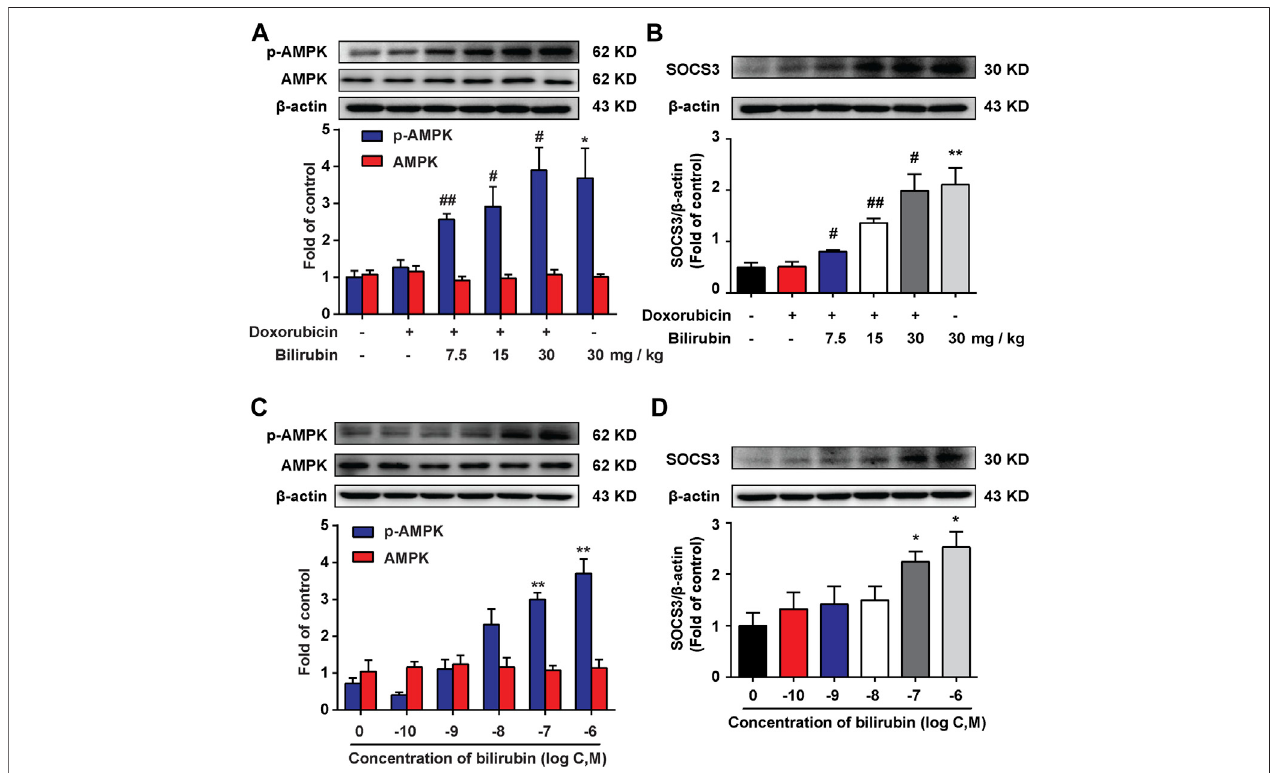
FIGURE 4 | Bilirubin increases AMPK phosphorylation and SOCS3 expression. (A,B) Representative western blot bands showed the levels of p-AMPK, AMPK, and SOCS3 in heart tissues from mice given different dosages of bilirubin (7.5, 15, and 30 mg/kg, i.p.) for 7 days, ( n = 4 of each group). (C,D) Representative Western blot bands shown the levels of p-AMPK, AMPK, and SOCS3 in H9C2 cells cultured with different concentrations of bilirubin for 6 h. Signi fi cant difference was revealed following one-way ANOVA (* p < 0.05, ** p < 0.01 vs. Control group; # p < 0.05, ## p < 0.01 vs. Doxorubicin-treated group; Bonferroni post hoc